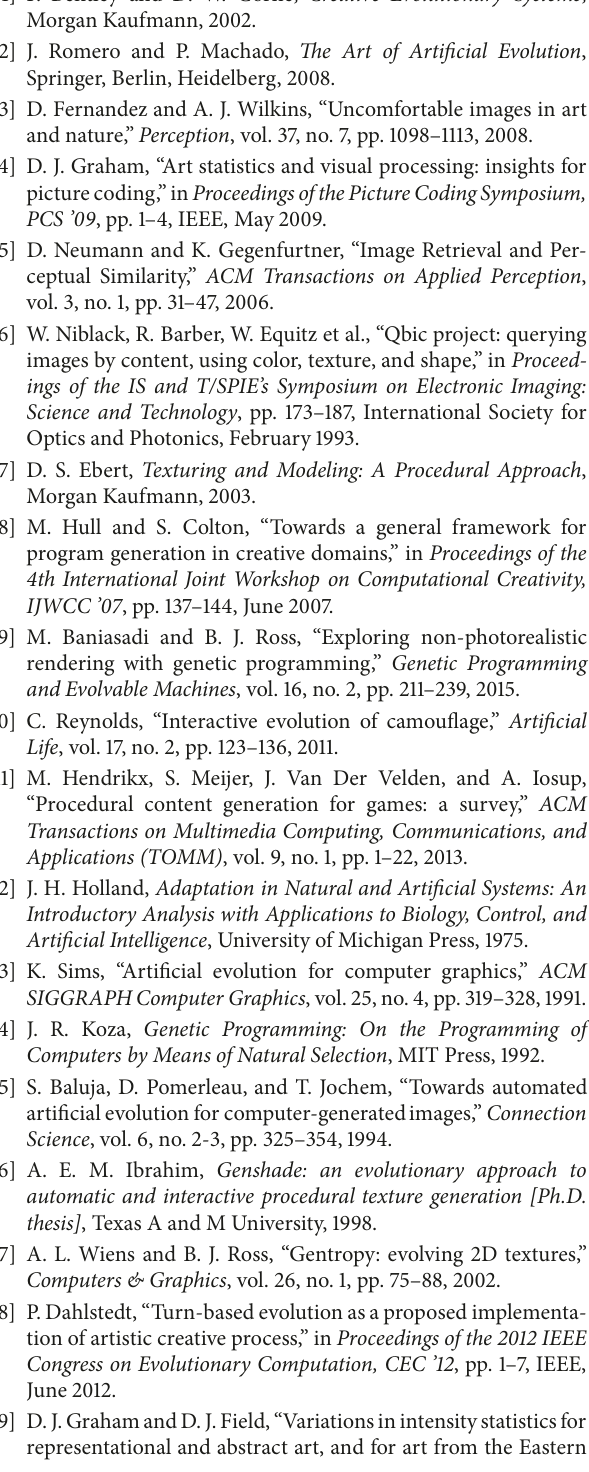
representational and abstract art, and for art from the